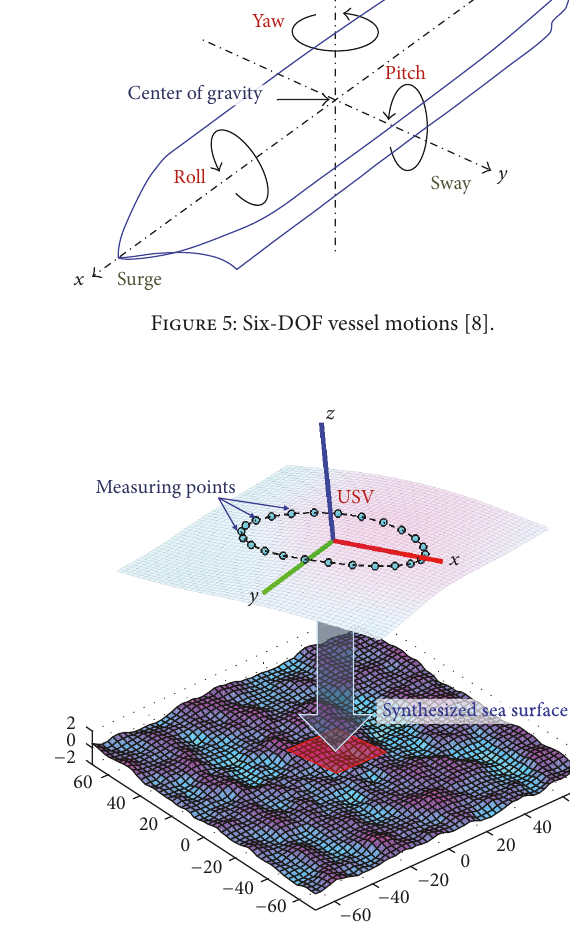
Figure 6: Measuring points for pose estimation of